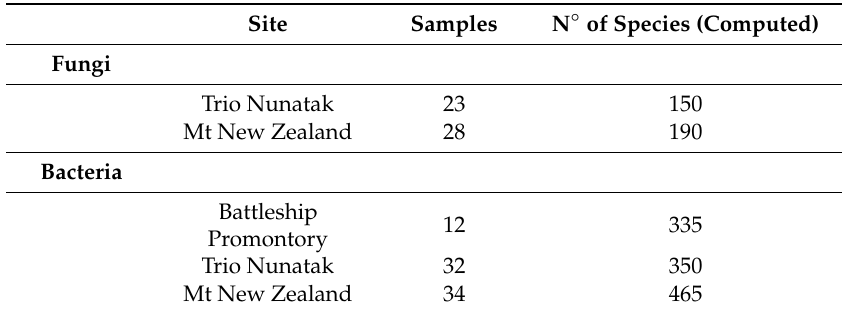
Table 1. Expected species richness values were computed for increased reference samples (sample-based extrapolation curves) using EstimateS with 95% confidence intervals.